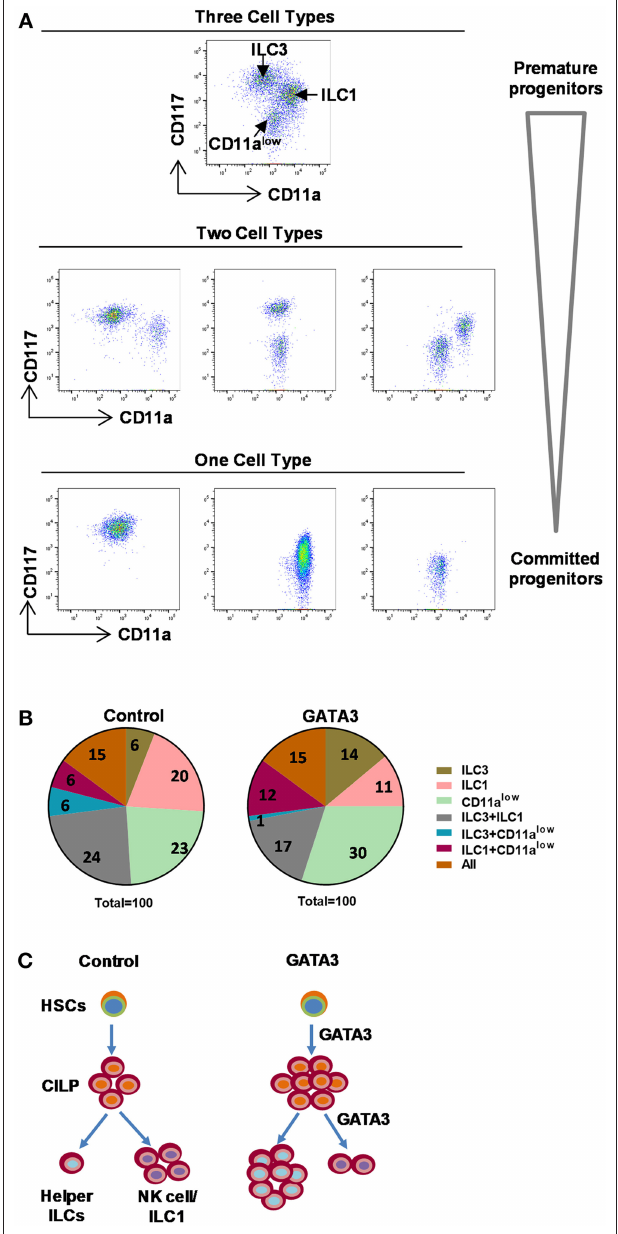
FIGURE 6 | Single cell cloning demonstrated GATA3 acts on committed progenitors. Either mock or GATA3 mRNA transfected CD34 + HSCs were single cell FACS sorted and differentiated for 28 days on pre-plated and irradiated EL08.1D2 stromal cell line in 96 well plates (39/384 for mock transfected and 42/384 for GATA3 transfected wells supported cell growth). (A) Cells were stained for ILCs surface markers at day 28 of culture and the representative dot plots show that single cells differentiated to either CD11a + CD94 + ILC1, CD11a − CD117 + ILC3, CD11a low CD117 − cells, a combination of two cell subsets or a combination of three cell subsets. (B) Cells were stained for ILCs surface markers at day 28 of culture and the percentage of wells showing either CD11a + CD94 + ILC1, CD11a − CD117 + ILC3, CD11a low CD117 − cells or a combination of two or three cell subsets are shown in parts of whole graphs. (C) GATA3 induces the generation of ILCPs from HSCs, and the differentiation of helper ILC lineage from committed progenitors. A schematic